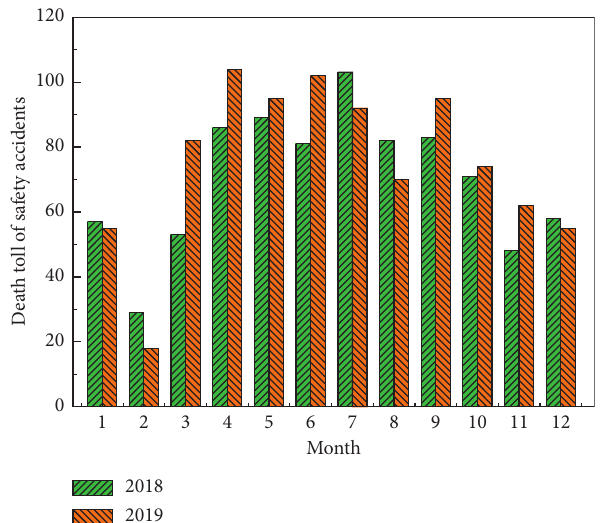
Figure 2: The death toll from production safety accidents in housing and municipal projects in China in